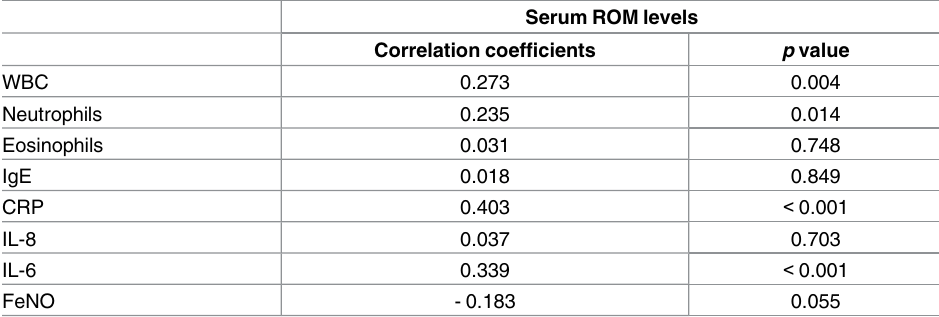
Table 2. Correlation Between Serum ROM Levels and